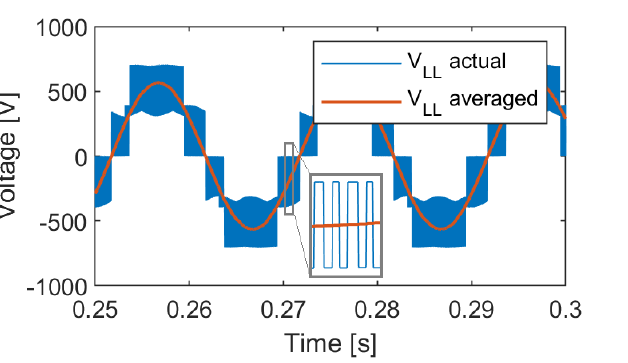
Figure 16. Three-phase three-level T-type rectifier simulation results: line-to-line voltage.